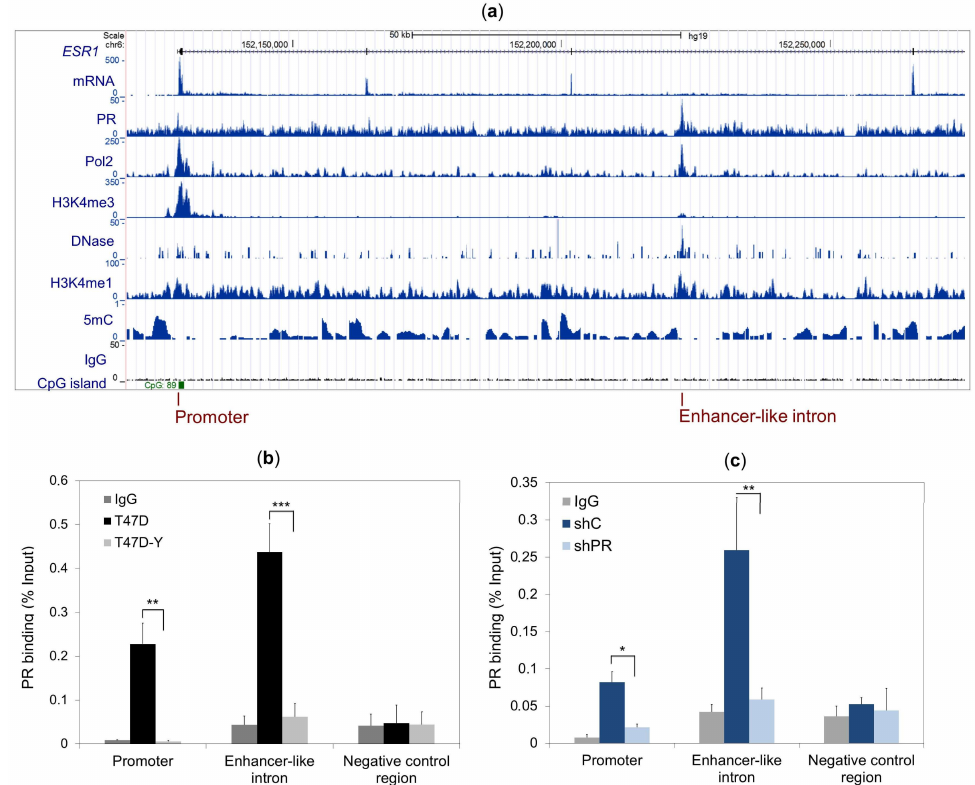
Figure 2. PR binds to the promoter and to an enhancer-like intron of the ESR1 gene in hormone-deprived T47D breast cancer cells. ( a ) Screen shot from the UCSC genome browser showing the ESR1 gene, the RNA reads and the ChIP-seq results from PR binding, with a peak at the gene promoter marked by polymerase 2 binding (Pol2), histone 3 trimethylated at lysine 4 (H3K4me3), low DNA methylation (5 mC) and a CpG island at the bottom. Another PR peak is found in an intronic region containing the classical enhancer epigenetic marks of the DNase hypersensitive site (DNase), histone 3 monomethylated at lysine 4 (H3K4me1) and low DNA methylation signal (5mC). The negative control immunoprecipitation is indicated by the IgG antibody. ( b , c ) The ChIP assay was performed with a specific antibody against PR or total rabbit IgG in T47D cells and PR-deficient cells (T47D-Y) ( b ) or PR-depleted cells (shPR, clone trcn0000010776) and control cells expressing a scrambled shRNA (shC) ( c ). Specific binding was assessed by quantitative PCR amplification of the ESR1 gene promoter, an enhancer-like intronic sequence and a genomic region localized at the 3 (cid:48) -end of the enhancer-like intron (negative control region). Error bars represent the SD of three independent experiments. * p less than or equal to 0.05, ** p less than or equal to 0.01, *** p less than or equal to 0.005, unpaired two-tailed Student’s t -test. We also tested PR binding at the ESR1 locus in MCF7 cells by ChIP-qPCR and found that in this case, the hormone-free PR also bound at the ESR1 promoter, but not at the enhancer-like site in the third intron of the ESR1 gene (Figure